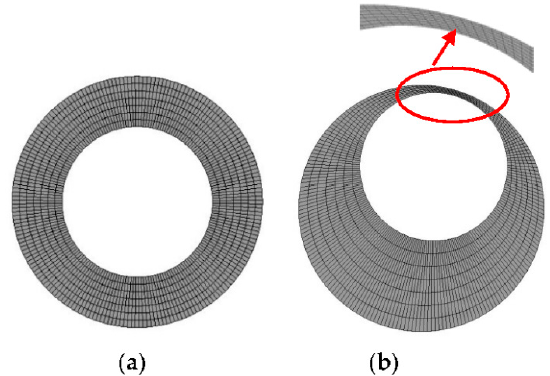
Figure 5. Front view of the meshed rotor: ( a ) initial grids, ( b ) moved grids.